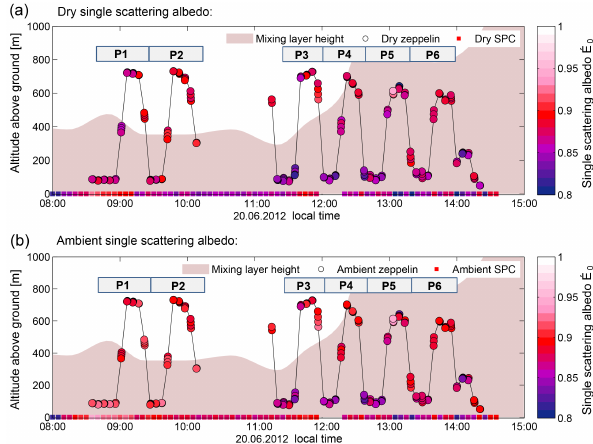
Figure 7. Time evolution of the dry (a) and ambient (b) single scat- tering albedo from the airborne and ground based platforms. The colour scale represents the magnitude of the coefficients. The uncer- tainty of the dry single scattering albedo is estimated to be ± 7 and ± 26% for SPC and the Zeppelin, respectively. The uncertainty of the ambient single scattering albedo is estimated to be ± 36 and ± 26% for SPC and the airborne data, respectively. Additionally, the shaded area in (a) and (b) denotes the estimated mixing layer height and each height profile ( P 1– P 6) is